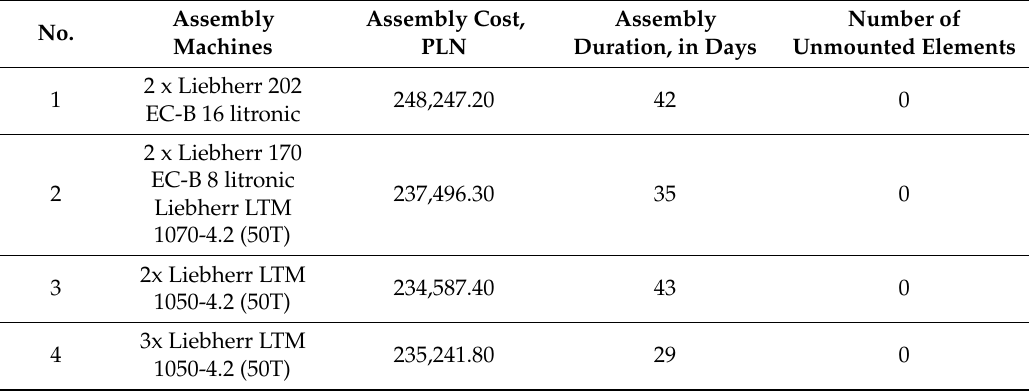
Table 4. Selected results of the computer aided assembly planning for the first 3 floors of the building-description in the text. Sourced from our own